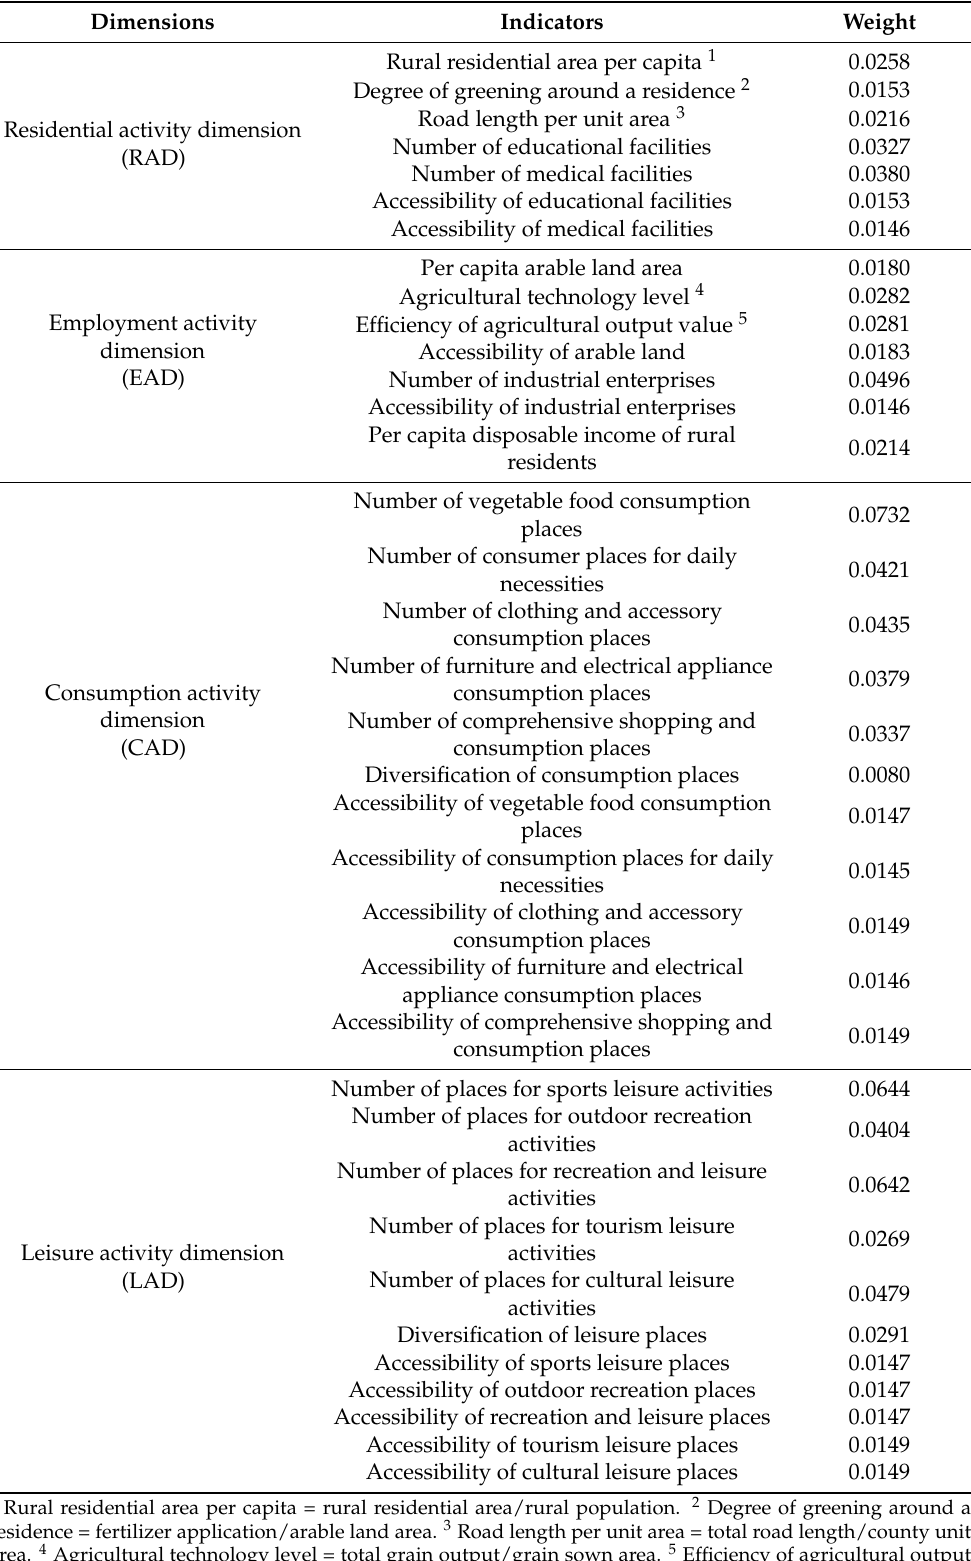
Table 3. Evaluation index system of the livability level of rural living